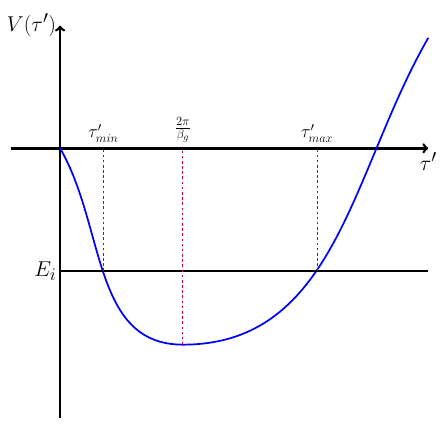
Figure 4 . The potential as a function of (cid:28) 0 is depicted in this (cid:12)gure. We also indicate the bounded motion and its energy which is